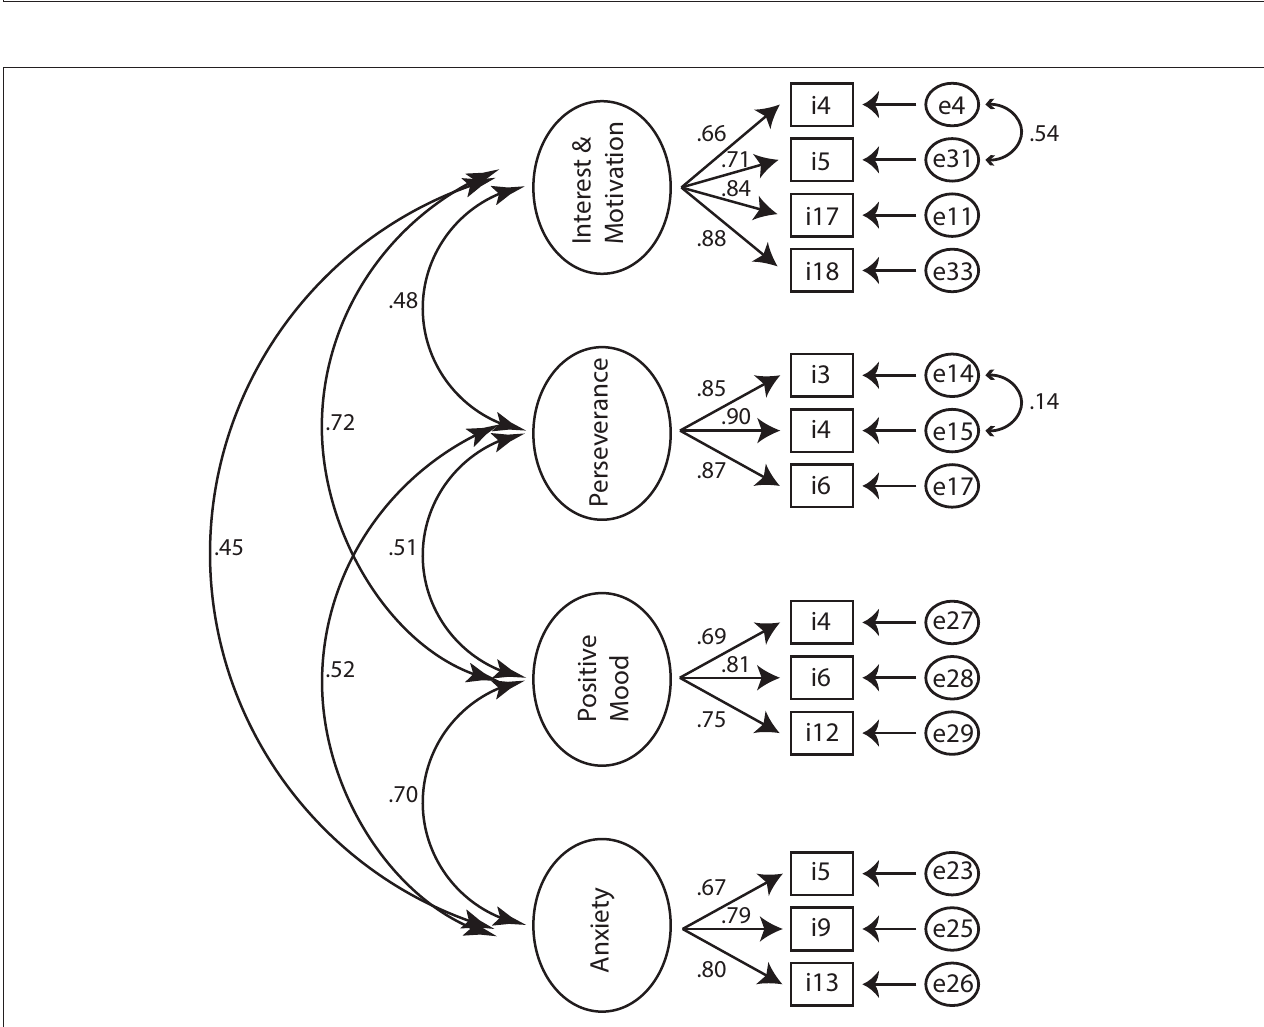
FIGURE 3 | Standardized estimates for the four-factor structure. Observed indicators (items) are enclosed in rectangles, latent variables (factors) in large circles, whereas measurement errors are enclosed in ellipses.